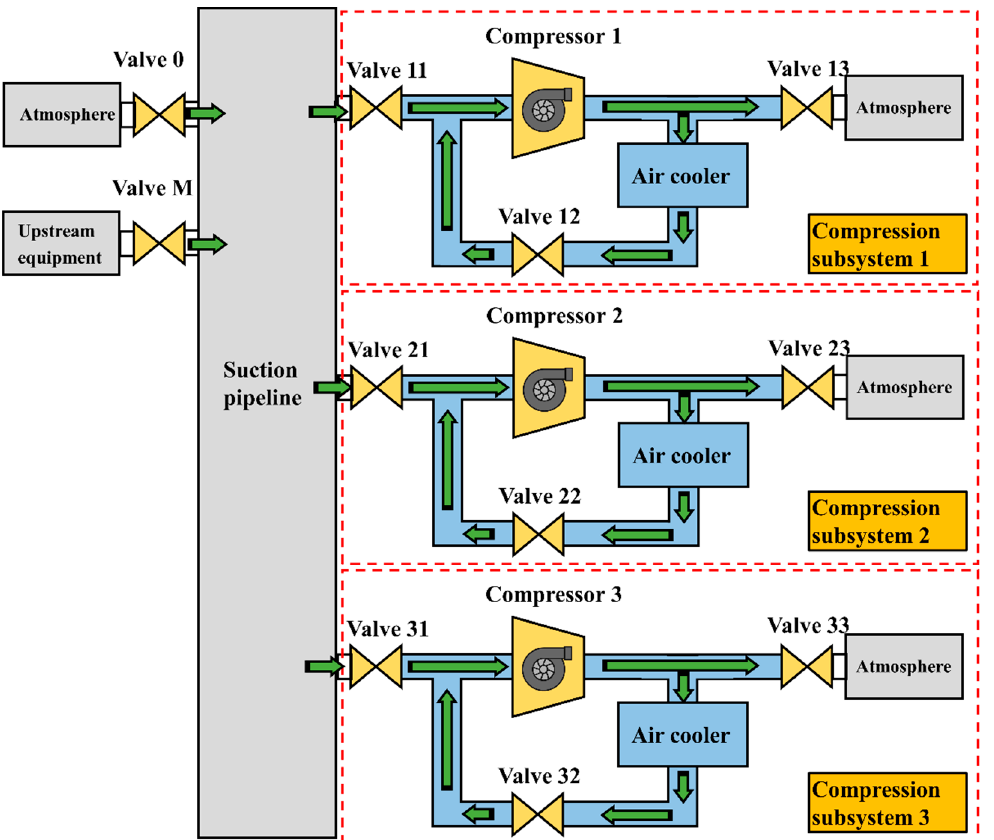
Figure 2. The structure diagram of an air suction compression system.